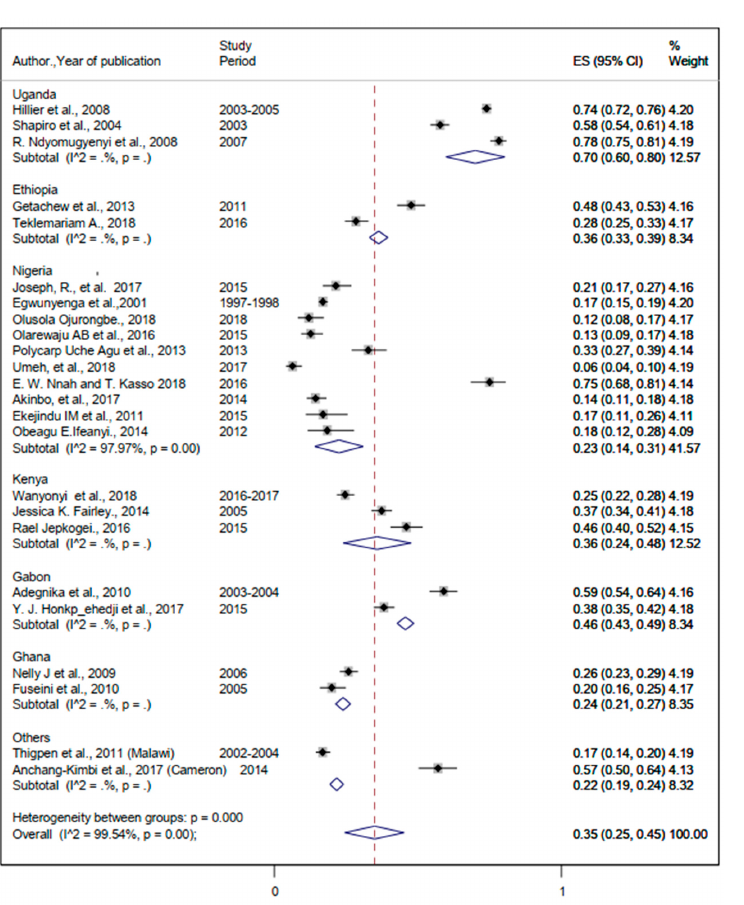
Figure 6. The proportion of Ascaris lumbricoides estimated from the overall helminthic infection among pregnant women in sub-Saharan Africa.